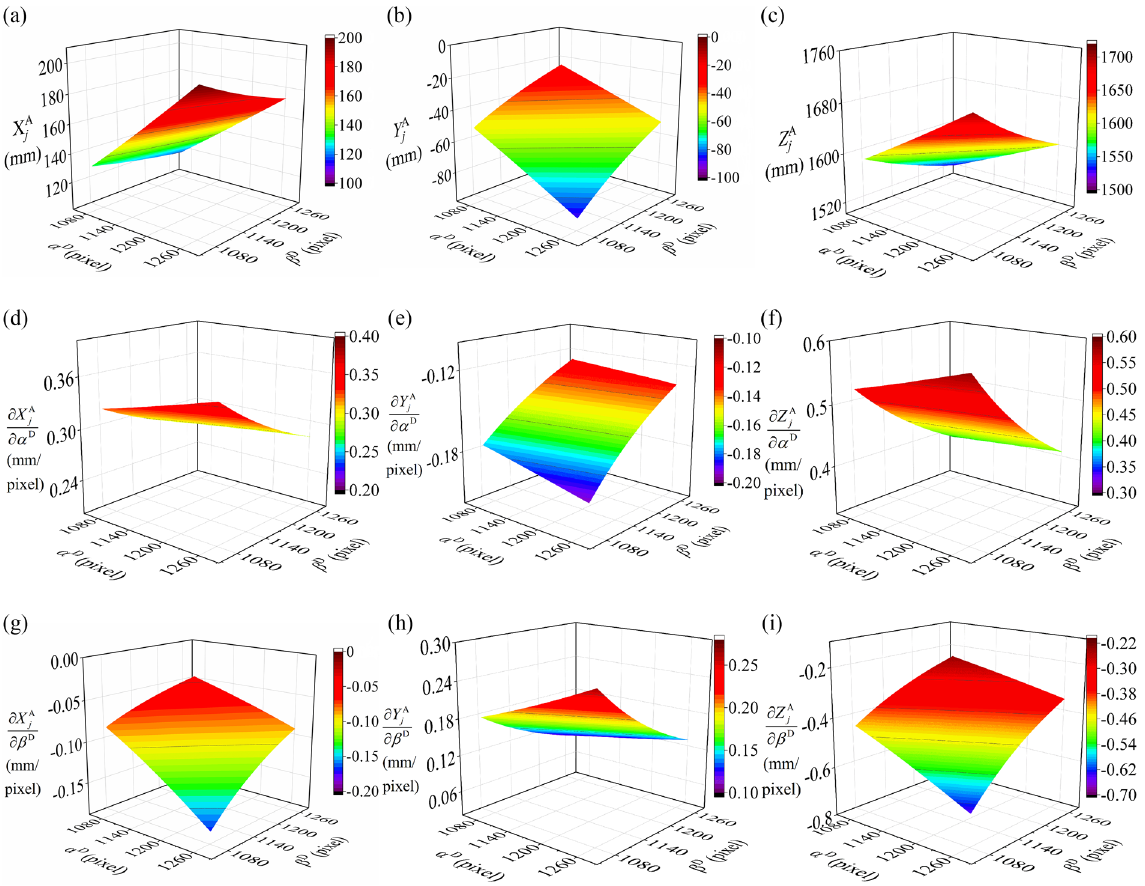
Figure 5. Simulation results of the intrinsic parameters α D , β D . ( a – c ) the relationship between the coordinates α D , β D . ( d – f ) the relationship between the partial derivatives X A Y A Z A j , j , j and the intrinsic parameters ∂ X A /∂α D , ∂ Y A /∂α D , ∂ Z A /∂α D and the intrinsic parameters α D , β D . ( g – i ) the relationship between the partial j j j derivatives ∂ X A j /∂β D , ∂ Y A j /∂β D , ∂ Z A j /∂β D and the intrinsic parameters α D , β D